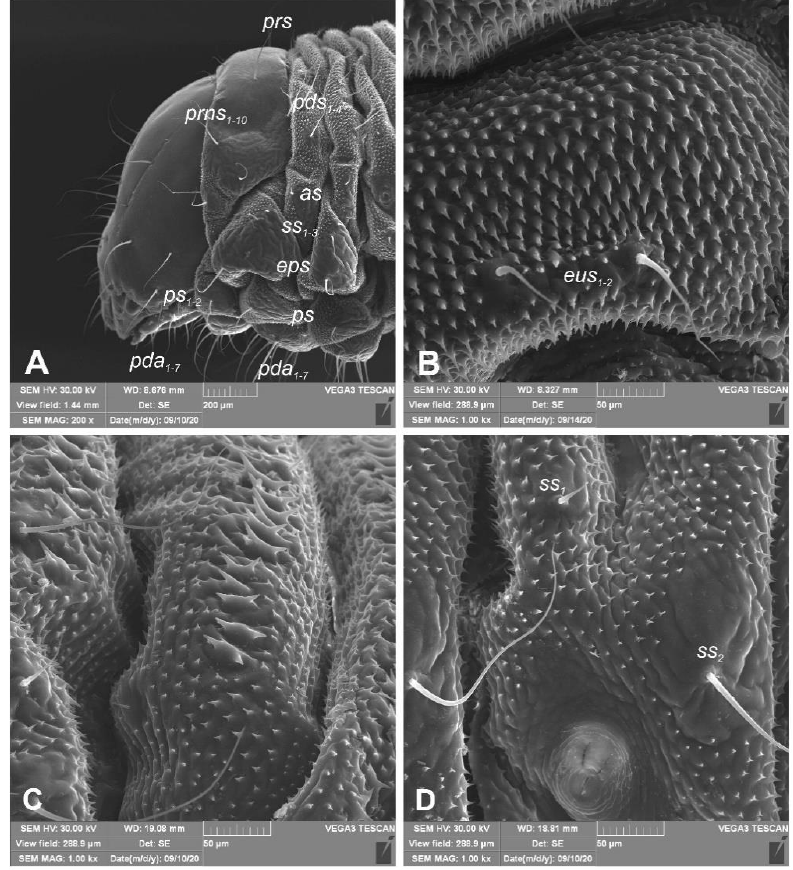
Figure 3. Euryommatus mariae mature larva, habitus, and cuticle (SEM micrographs, TESCAN ORSAY HOLDIND, Brno, Czech Republic). ( A ) Lateral view of head and thorax; ( B ) ventral view of the abdominal segment I; ( C ) dorsal view of the abdominal segment I; ( D ) lateral view of the abdominal segment I (setae: as —alar, ps —pleural, eps —epipleural, eus —eusternal, pda —pedal, pds —postdorsal, prns —pronotal, prs —prodorsal, ss —spiracular).